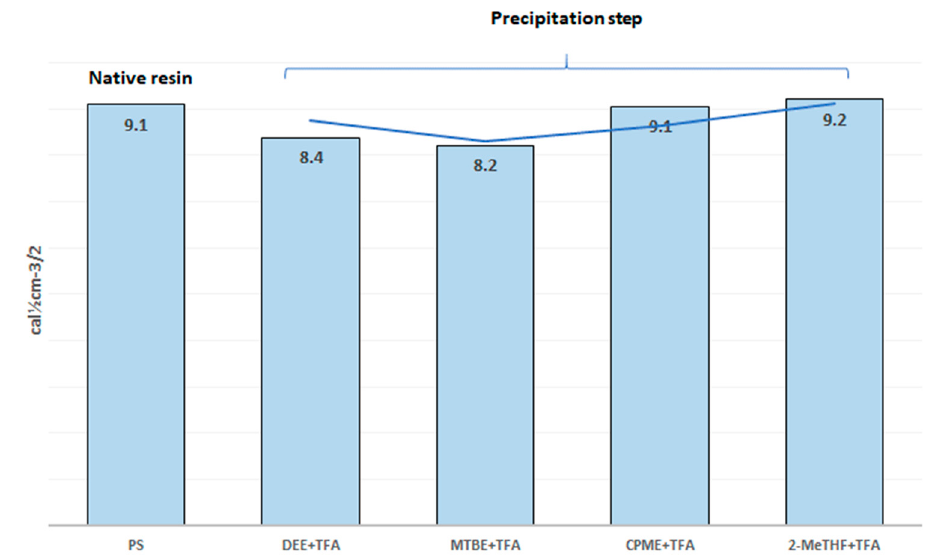
Figure 2. Solubility parameters of PS and ethers used in SPPS protocol. Solubility parameter of each ether was revised based on the ratio of each mixture, [ether-trifluoroacetic (TFA) (5:1)]. SEM was used to monitor the morphological structure of the CTC resin at several stages: (i) before starting the synthetic process (native resin); (ii) after the synthetic process (protected peptide anchored on the resin); (iii) after the cleavage step and the addition of the chilled precipitating ether (resin and the cleaved peptide); and, (iv) after the regeneration step. SEM analyses are interpreted in terms of the solubility parameter of 1% divinylbenzene (DVB) crosslinked PS and the corresponding